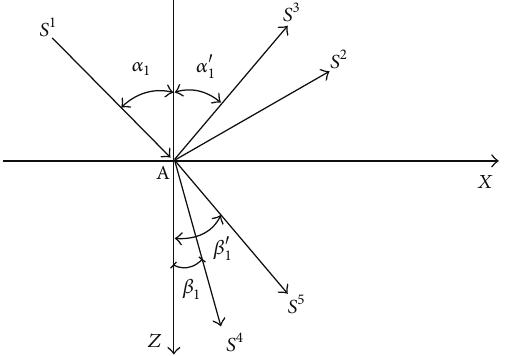
Figure 11: Analysis model of reflection and refraction at any point